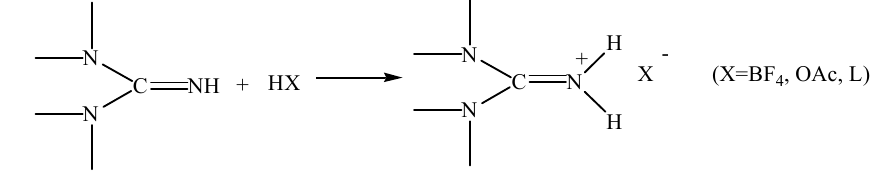
Scheme 2. Synthetic scheme for [TMG]-based ionic liquids (ILs).